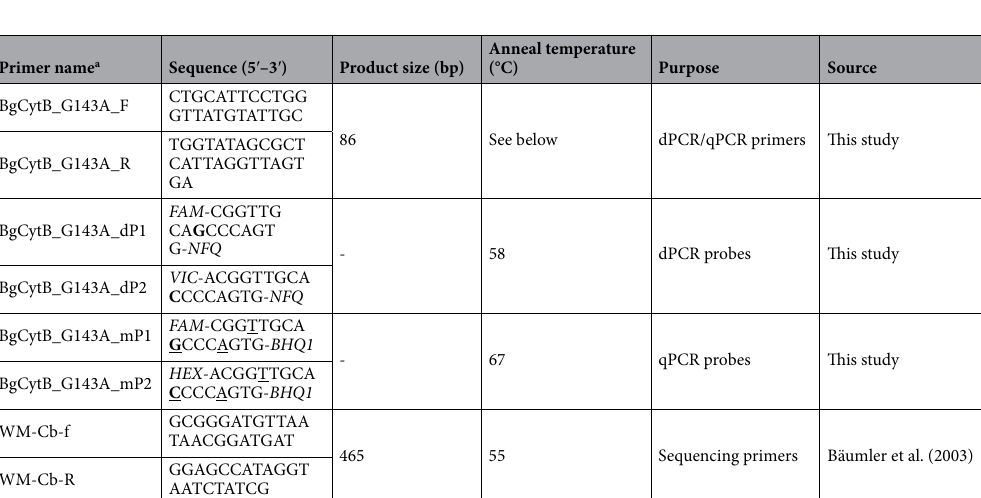
Table 2. PCR, Digital PCR and qPCR primers and probes used in this study. a The probes dP1 and mP1 target the cytb A143 allele whereas probes dP2 and mP2 target the G143 wild-type allele. Italics—fluorophore/ quencher; bold—single nucleotide polymorphism; underlined—locked nucleic acid.